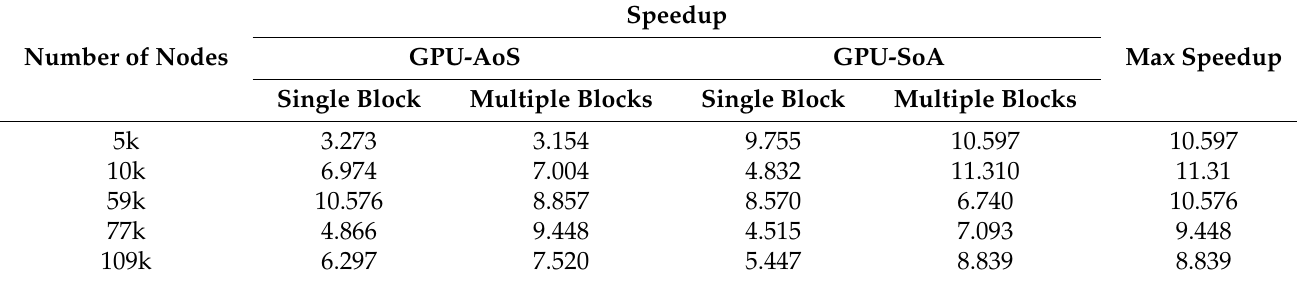
Table 5. Speedup of the proposed algorithm over serial algorithm when using Form A.